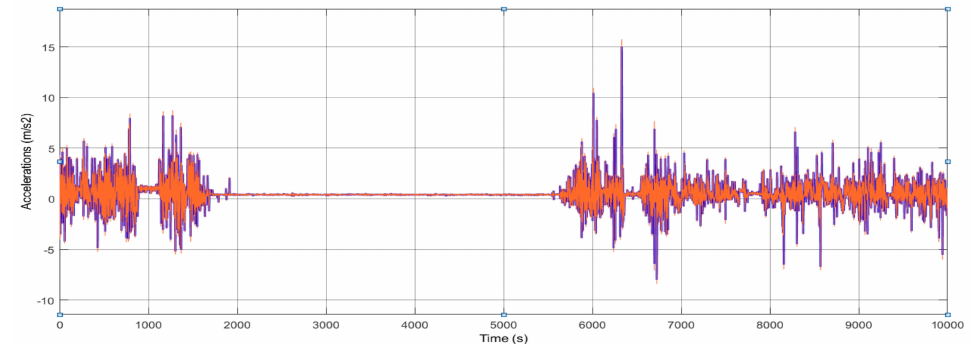
Figure 8. Original IMU recorded data versus MAF data (Orange: Recorded data, Blue: Averaged data with window size =